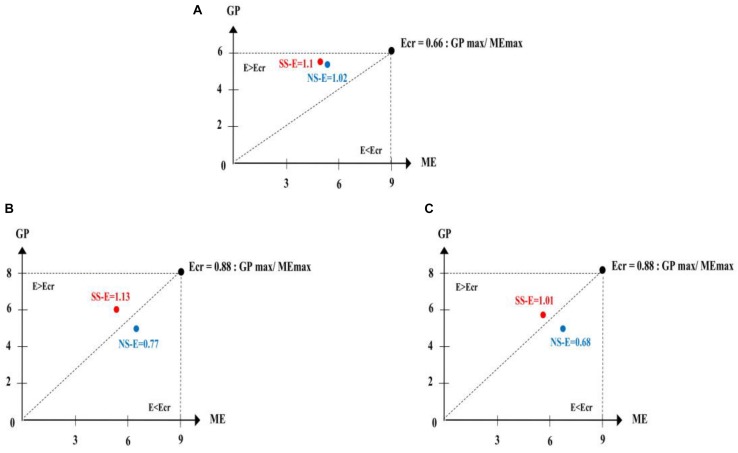
Learning efficiency as a function of presentation speed and content complexity (A = low complexity, B = medium complexity, C = high complexity). The diagram is a representation after Kalyuga and Sweller (2005), where ME = mental effort, GP = game performance, SS-E = efficiency with a slow-speed, NS-E = efficiency with a normal-speed, and Ecr = critical efficiency.